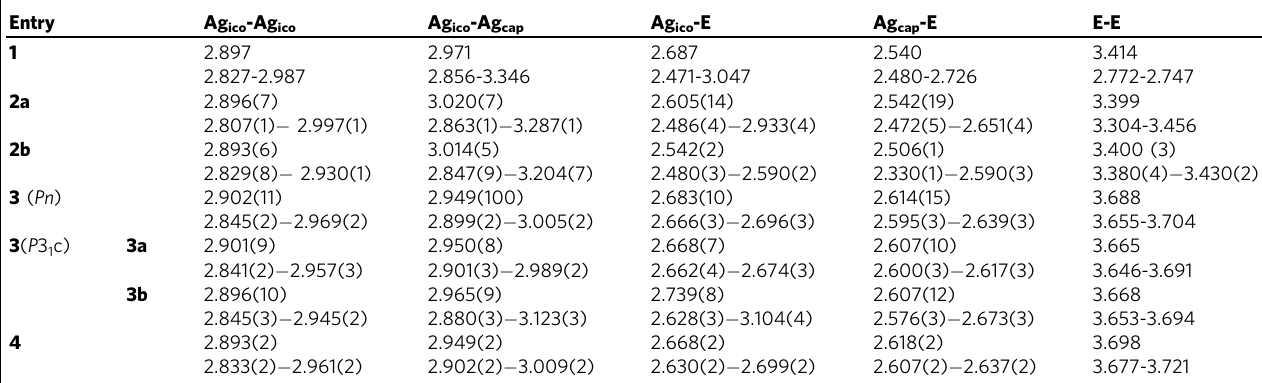
Table 2 Selected structural metrics (average (top line) and ranges (bottom line)) of compounds for 1, 2a-b, 3, 3a-b and 4.